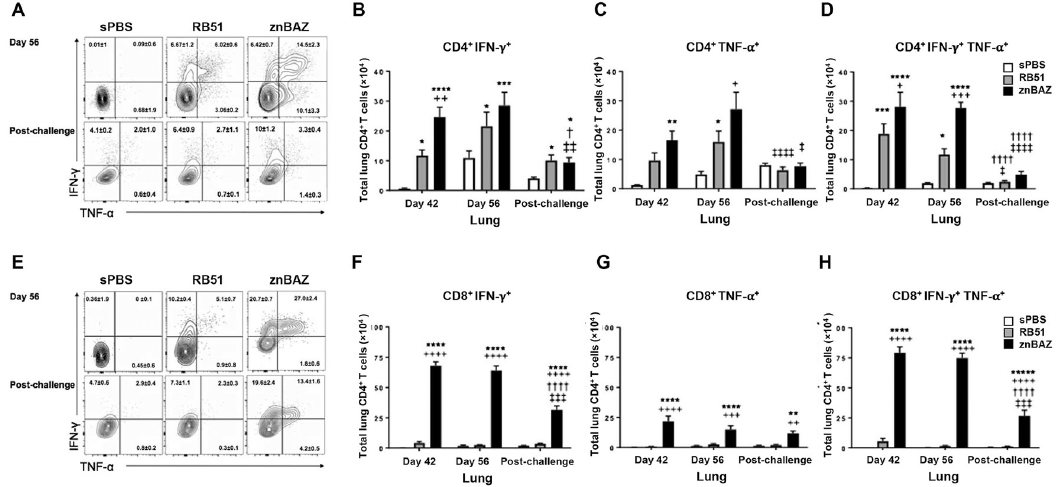
Fig 3. Mucosal znBAZ enhances polyfunctional T cell responses. BALB/c mice were primed and boosted with sPBS, RB51, and znBAZ as described in (Fig 1A). Mice were analyzed for the expression of proinflammatory cytokines pre- and post-wt B . abortus 2308 challenge. (A) Flow cytometry of IFN- γ and TNF- α expression by CD4 + T cells in the lungs on day 56. (B-D) total numbers of IFN- γ - and TNF- α -producing CD4 + T cells are depicted for days 42, 56, and 84 post-primary immunization. (E) Flow cytometry of IFN- γ and TNF- α expression on CD8 + T cells in the lungs on day 56. (F-H) Total numbers of IFN- γ - and TNF- α -producing CD8 + T cells are depicted for the same time points described above. The data depict n = 12 mice per group from two independent experiments. The differences were determined when compared to sPBS-dosed mice ( ���� P < 0.0001, ��� P < 0.001, �� P < 0.01, � P < 0.05), or compared to RB51-vaccinated mice ( ++++ P < 0.0001, +++ P < 0.001, ++ P < 0.01, + P < 0.05). The differences between time points were determined when compared to day 42 ( †††† P < 0.0001, ††† P < 0.001, †† P < 0.01, † P < 0.05), or compared to day 56 ( ‡‡‡‡ P < 0.0001, ‡‡‡ P < 0.001, ‡‡ P < 0.01, ‡ P < 0.05). Analysis of variance with Two-way ANOVA Tukey’s multiple comparisons test was